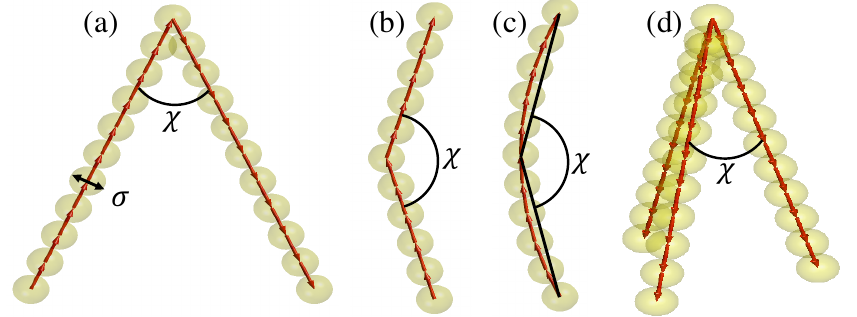
Figure 2. Model particles considered in this work; σ is the hard sphere diameter, and χ is the bend angle, equal to 45 ◦ in ( a ), 150 ◦ in ( b ), 155 ◦ in ( c ) and 25 ◦ in ( d ).